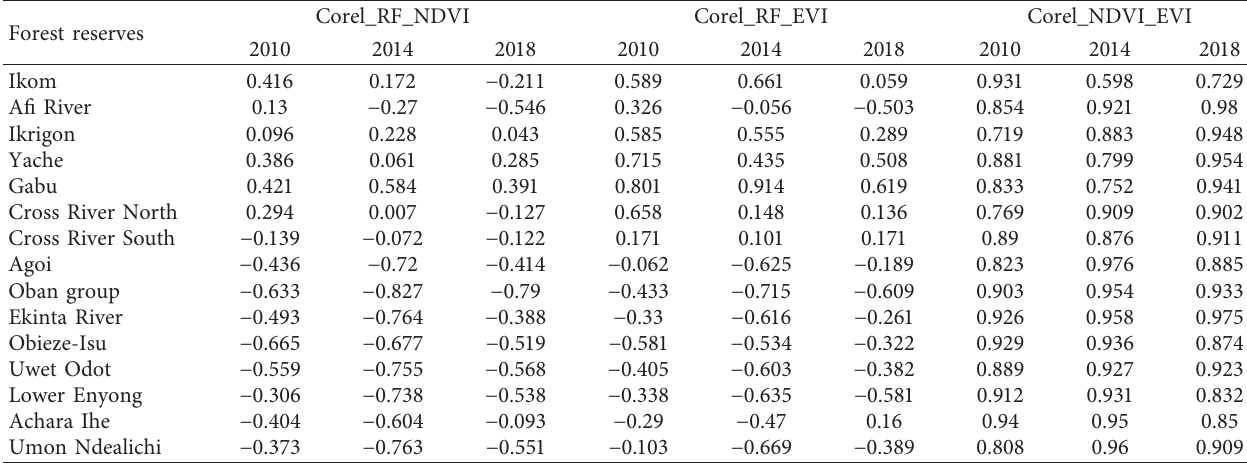
Table 3: Correlation coefficients for monthly